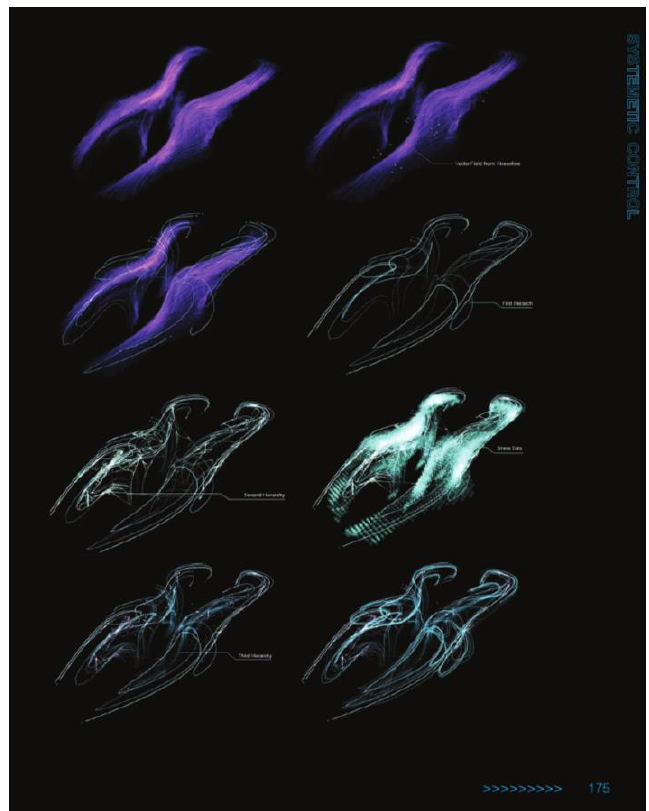
Figure 15. Parallel to typological and organizational developments the study was structured in phases that investigate the relationship between formal spatial organization and programmatic relationships that were taken up to a level of experiential